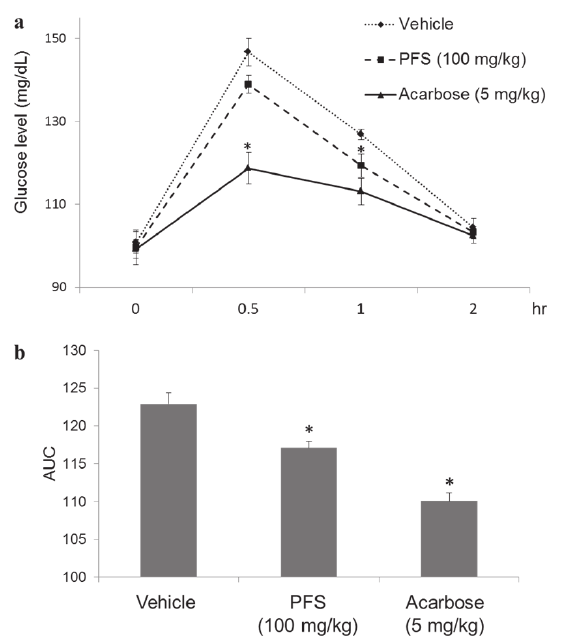
Figure 4 - Hypoglycemic effect of saponin PFS. a ) Blood glucose levels after 4 g/kg sucrose administration in normal mice. b ) The incremental AUC in normal rats after 0-120 min sucrose administration. Bars represent mean ± SD (n = 6), * p <0.05 compared with